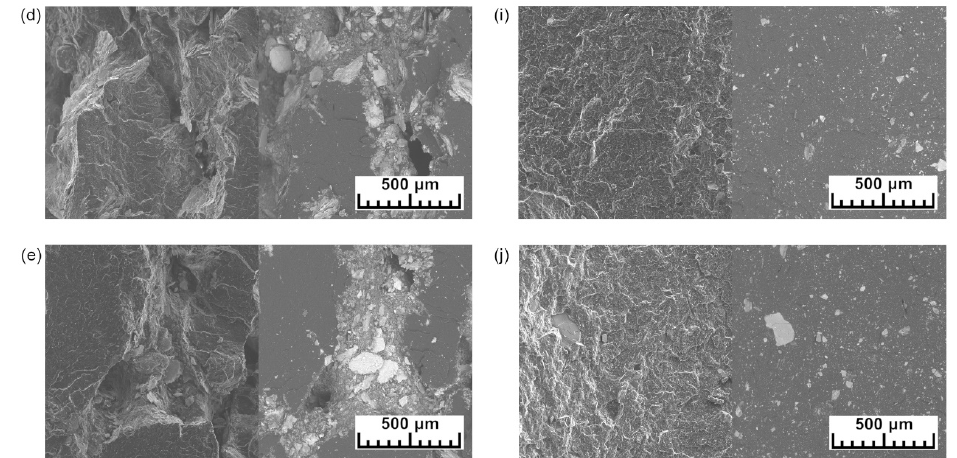
Figure 5. SEM images of cryo-fractured rotomolded samples: dry blended with 0.5 ( a ), 1 ( b ), 2 ( c ), 5 ( d ), and 10 wt% ( e ) of EV and melt compounded with 0.5 ( f ), 1 ( g ), 2 ( h ), 5 ( i ), and 10 wt% ( j ) of EV in the SE and BSE modes.